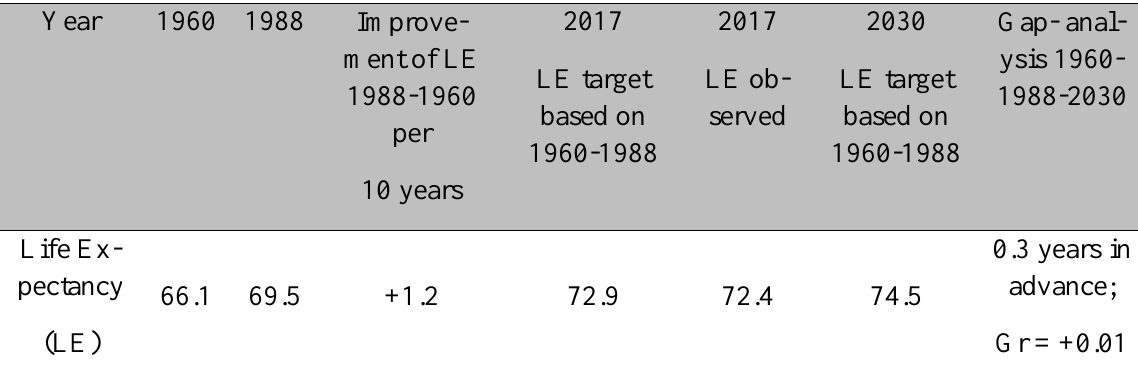
Table 3. Life Expectancy at birth according to the trajectory 1960-1988 for the Russian Federation targeting 2017 and 2030 along the same